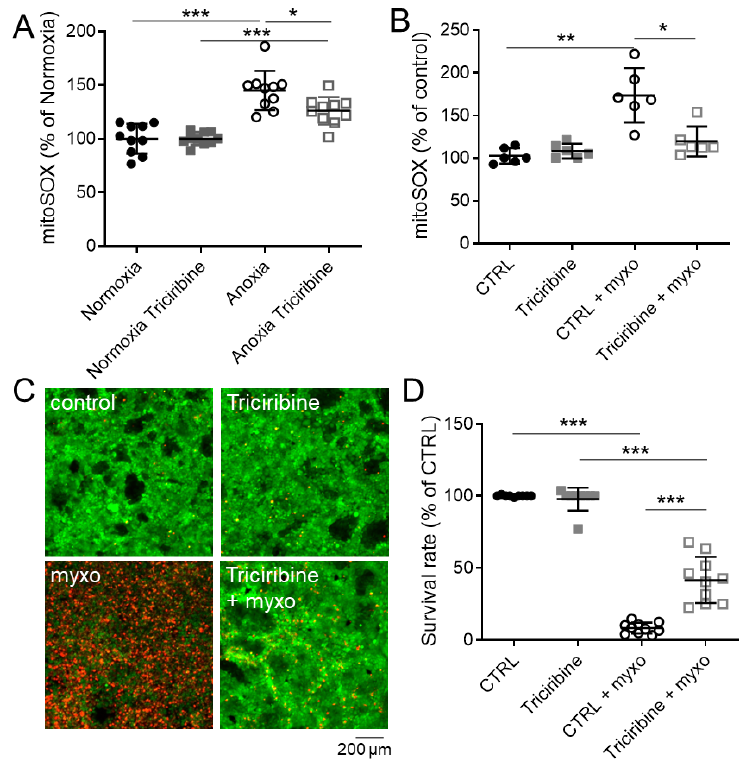
Figure 4. Effect of Akt inhibition on mitochondrial ROS production. ( A , B ) Mitochondrial ROS con- tent evaluated with MitoSOX probe on PCT cells treated or not 24 h with triciribine (1 µM) and then submitted to anoxia for 8 h ( A ) or treated with 1 µM myxothiazol for 6 h ( B ). Fluorescence was measured on cell lysate and normalized by protein content. ( C , D ) Cell viability was evaluated using a live/dead fluorescence assay on PCT cells treated 24 h with triciribine (1 µM) and then with 1 µM myxothiazol for 24 h. ( C ) Representative images for each condition with live (green, calcein-FITC) and dead (red, ethidium bromide homodimer) cells and ( D ) corresponding survival rate (live/dead cells). Scatter plot representation of individual values along with mean ± Sd. n = 10 ( A , D ) or 6 ( B ). * p < 0.05; ** p < 0.01, *** p < 0.001.